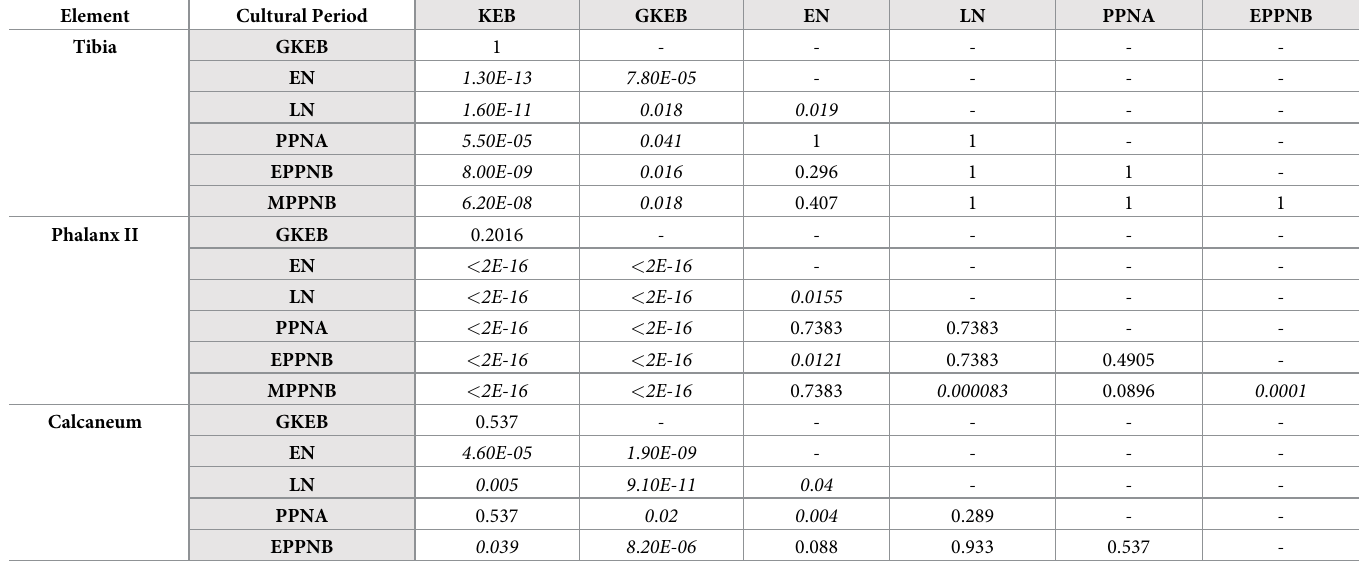
Italicized values are significant at the p < 0.05